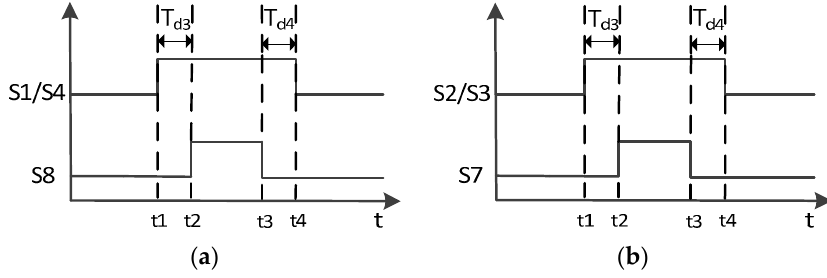
Figure 14. Gate signals of IGBT and MOSFET ( a ) The positive cycle; and, ( b ) The negative cycle.